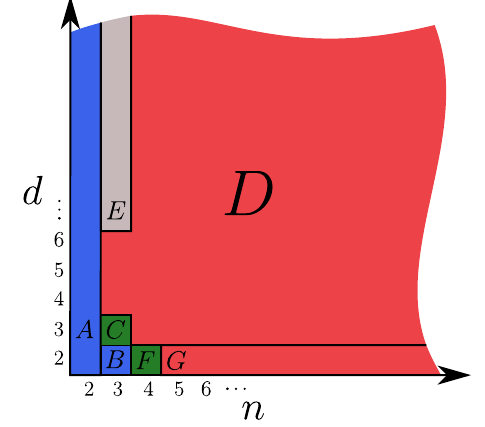
FIG. 1. Summary of results on the symmetries of n -partite systems with local dimension d . The picture is divided into different regions (A to G) that were treated separately in the literature. The colors give information on the stabilizer of states in the corresponding system: blue (all states have a noncompact stabilizer, regions A [8] and B [19,25]), green (generic states have a finite, nontrivial stabilizer, regions C [18] and F [19]); red [generic states have a trivial stabilizer, regions D (see Theorem 1) and G [21] ]; grey (generic states have a finite stabilizer [17,26], unknown if it is trivial, region E). The implications of these and other results in entanglement theory are summarized in the main